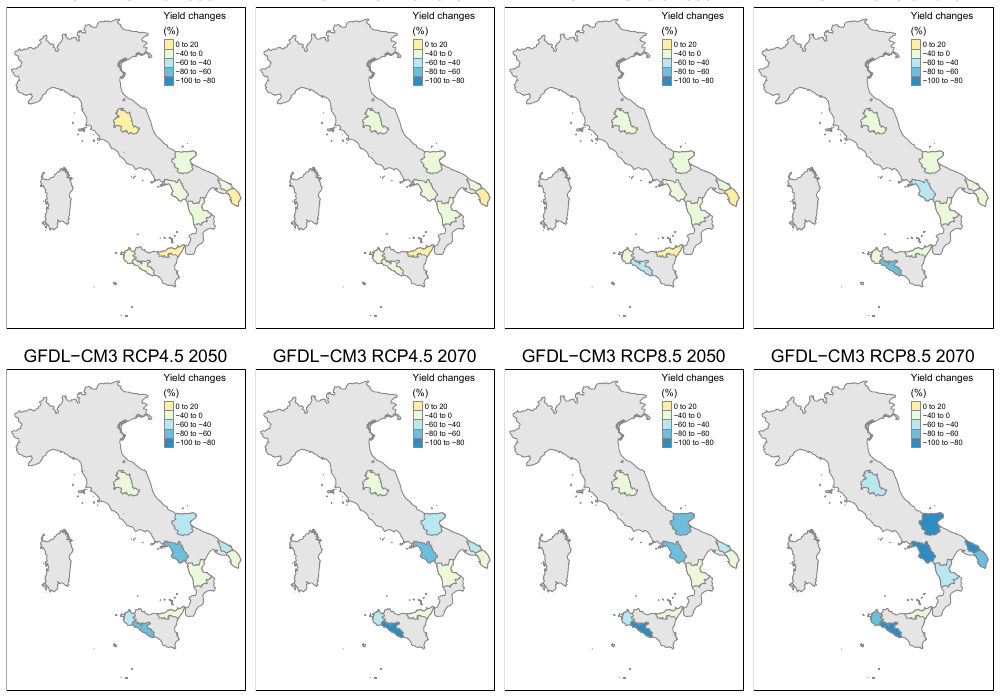
Figure 4. Changes of olive production (percentage) in the most pessimistic (GFDL-CM3) and optimistic (INM-CM4) General Circulation Model under two scenarios of emission (Representative Concentration Pathways, 4.5 and 8.5 W/m 2 ) for two time periods (2050 and 2070).